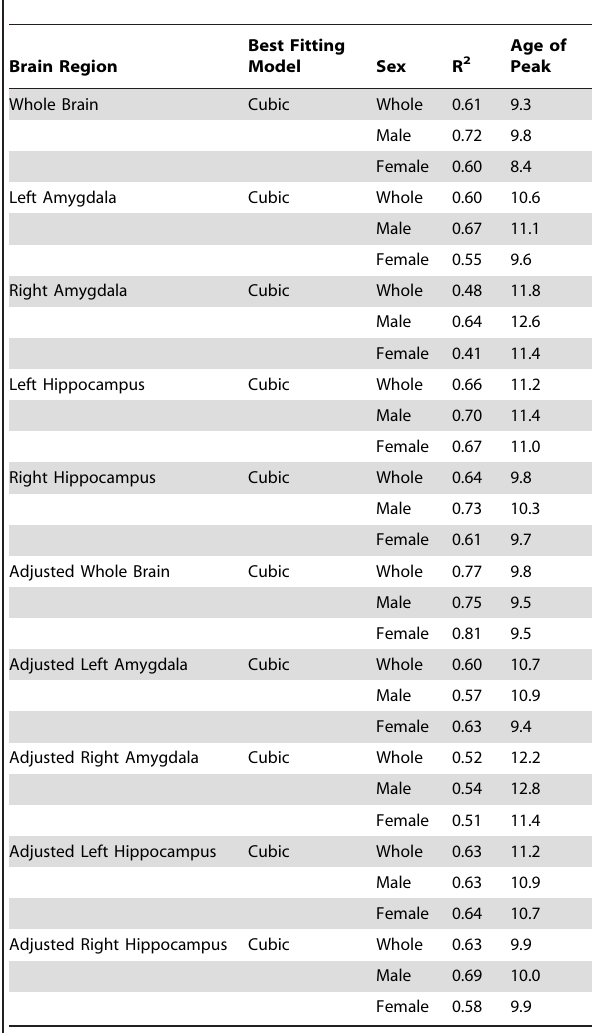
Table 2. Best fitting developmental trajectory model with peak ages.